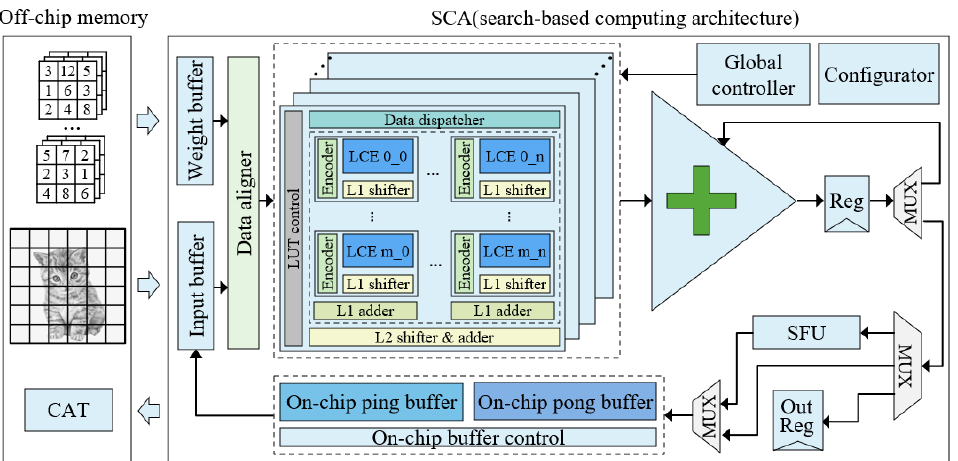
Figure 10. Search-based computing architecture (SCA). Off-chip memory stores input images, weight, and output results. SCA completes the calculation of the whole network.